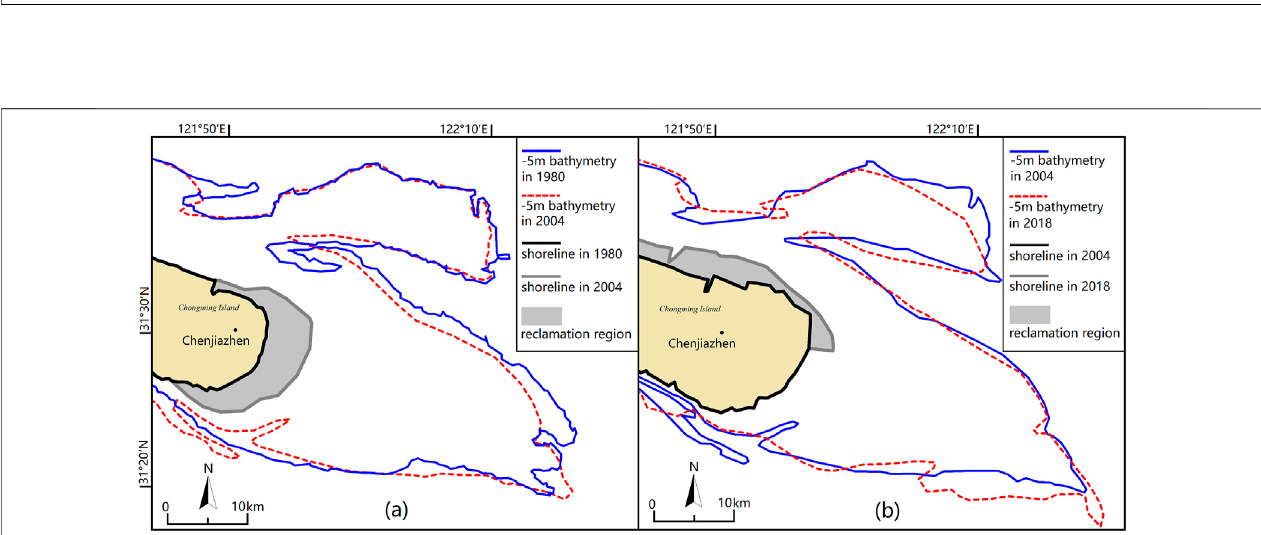
Frontiers in Environmental Science |